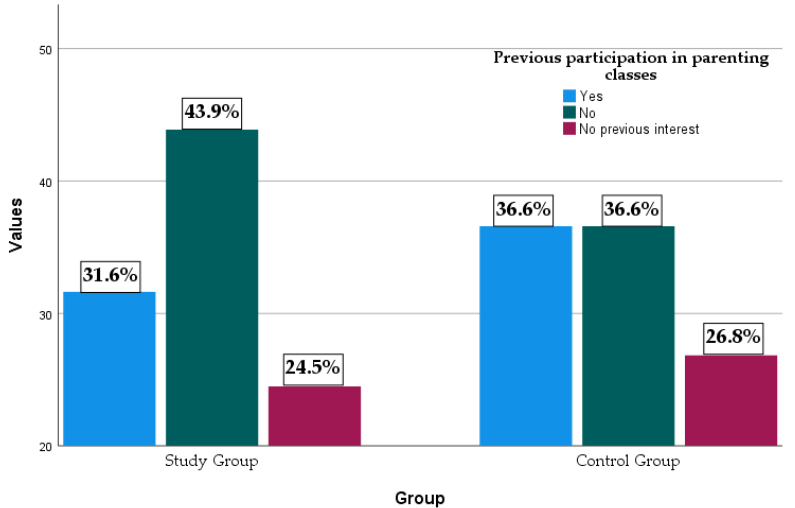
Figure 3. Distribution of enrolled PWs according to previous participation in parenting classes.